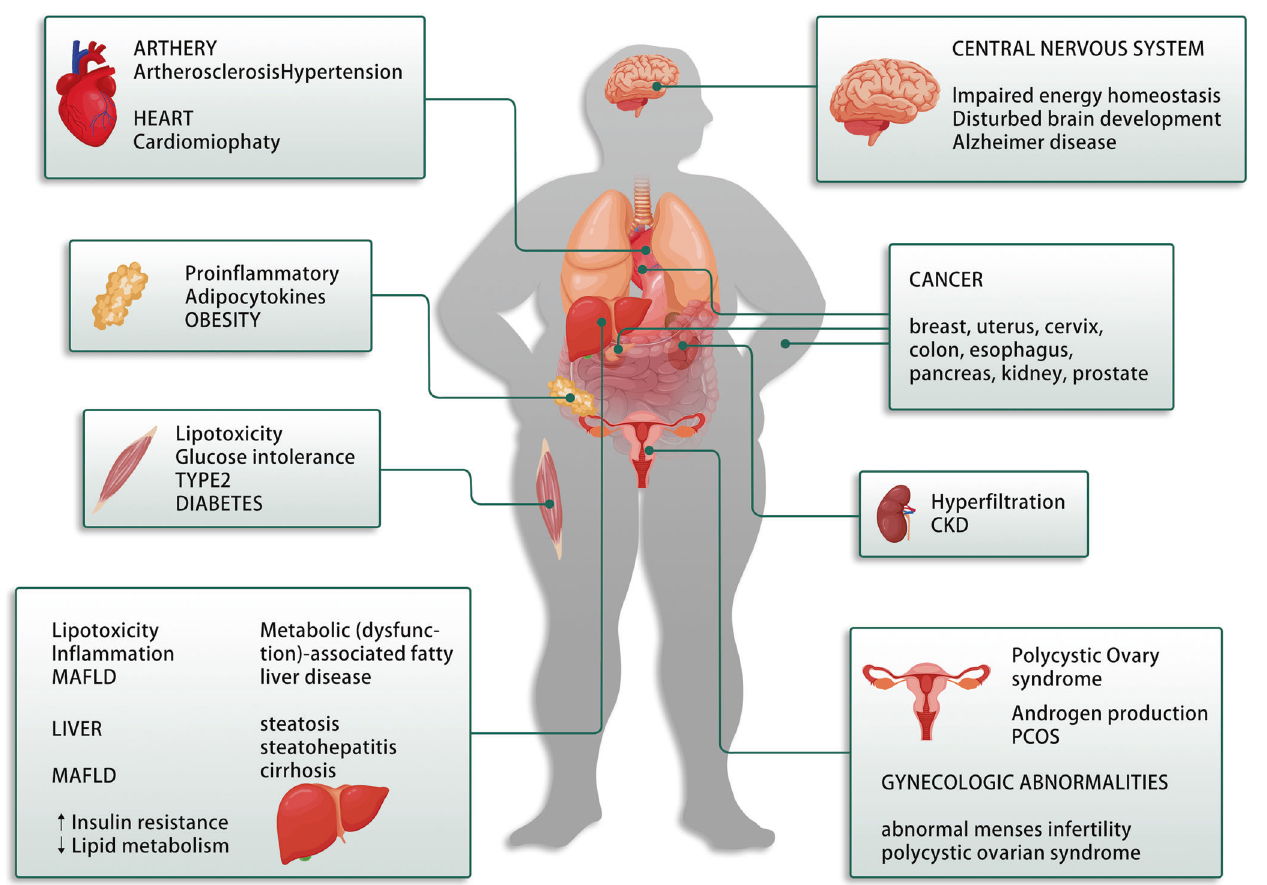
Fig. 4 Insulin resistance related diseases in